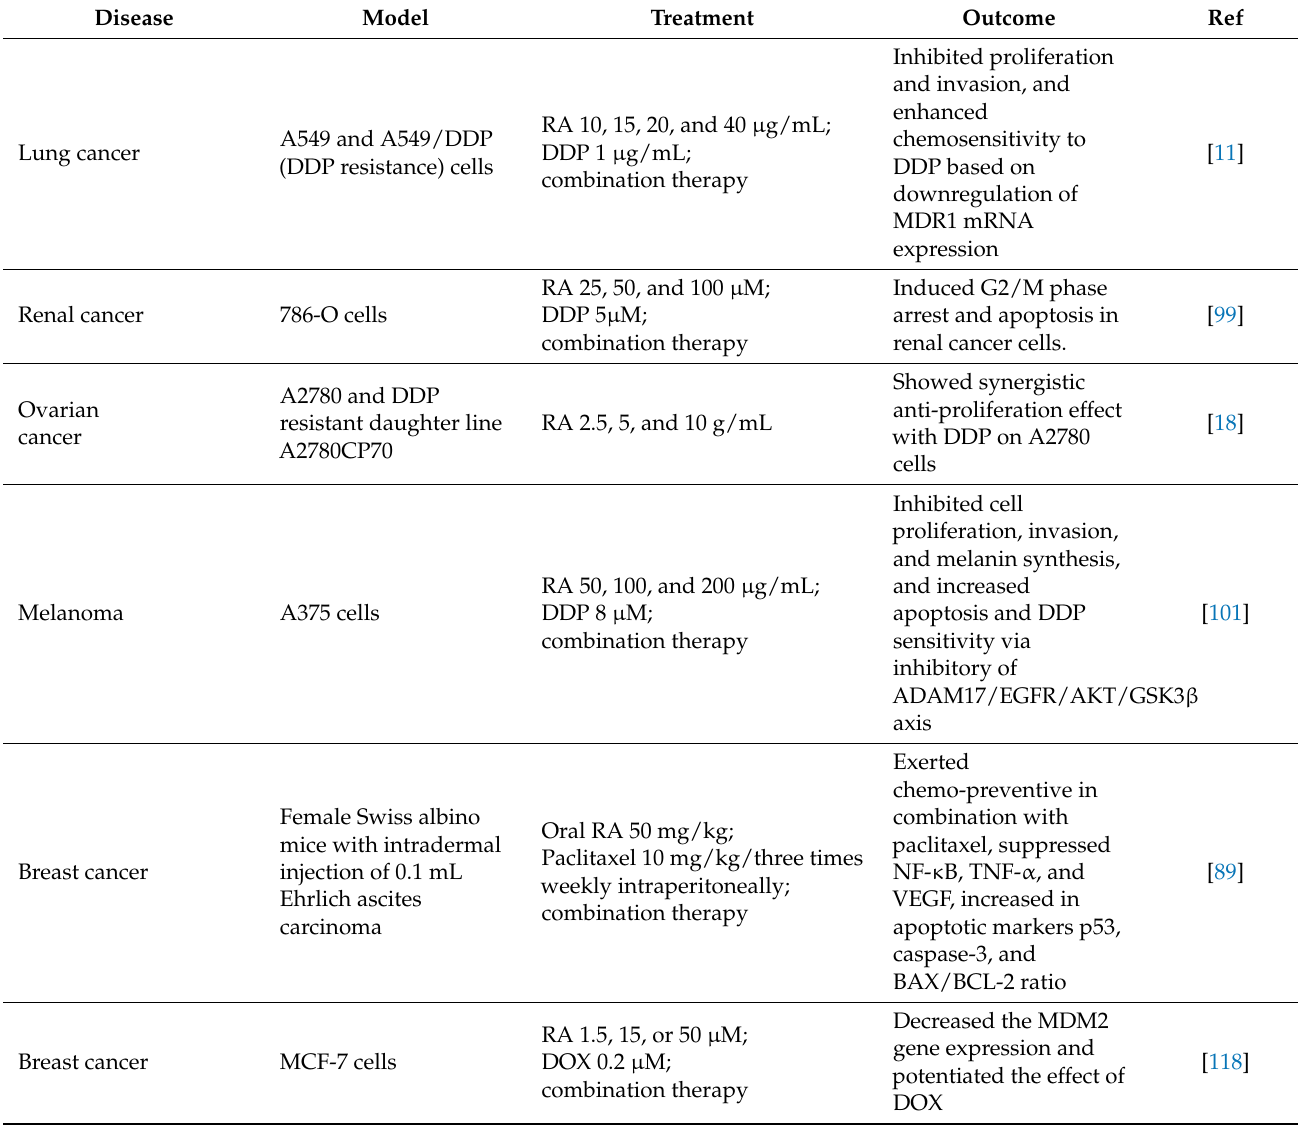
Table 4. Summary of RA as chemosensitizers in tumor